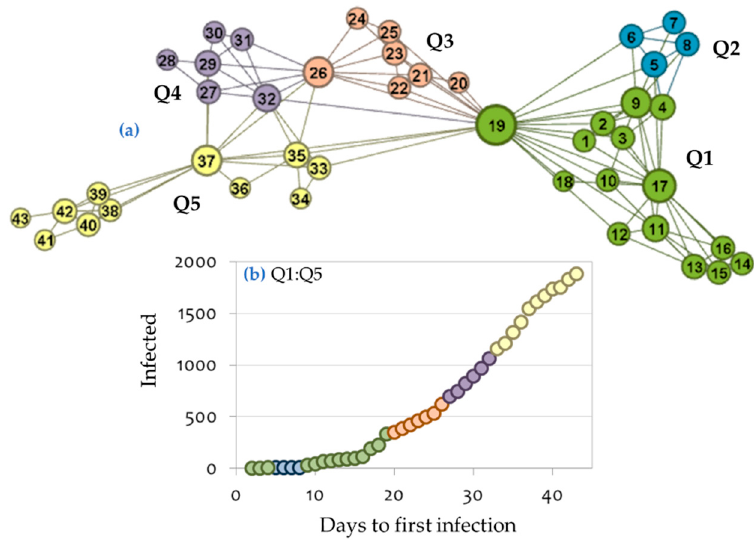
Figure 9. Community detection of the Greek COVID ‐ 19 infection visibility graph based on the modularity optimization algorithm of [40]. Node size in the network is proportional to node